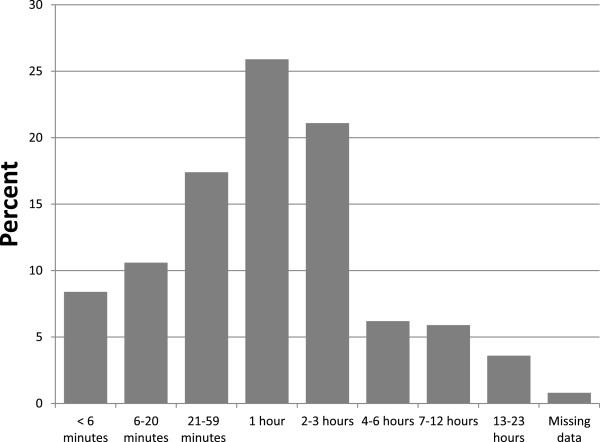
Time of death for 2733 infants dying within 24 hours after birth. Percentages of early neonatal (infant) deaths by time intervals after birth.